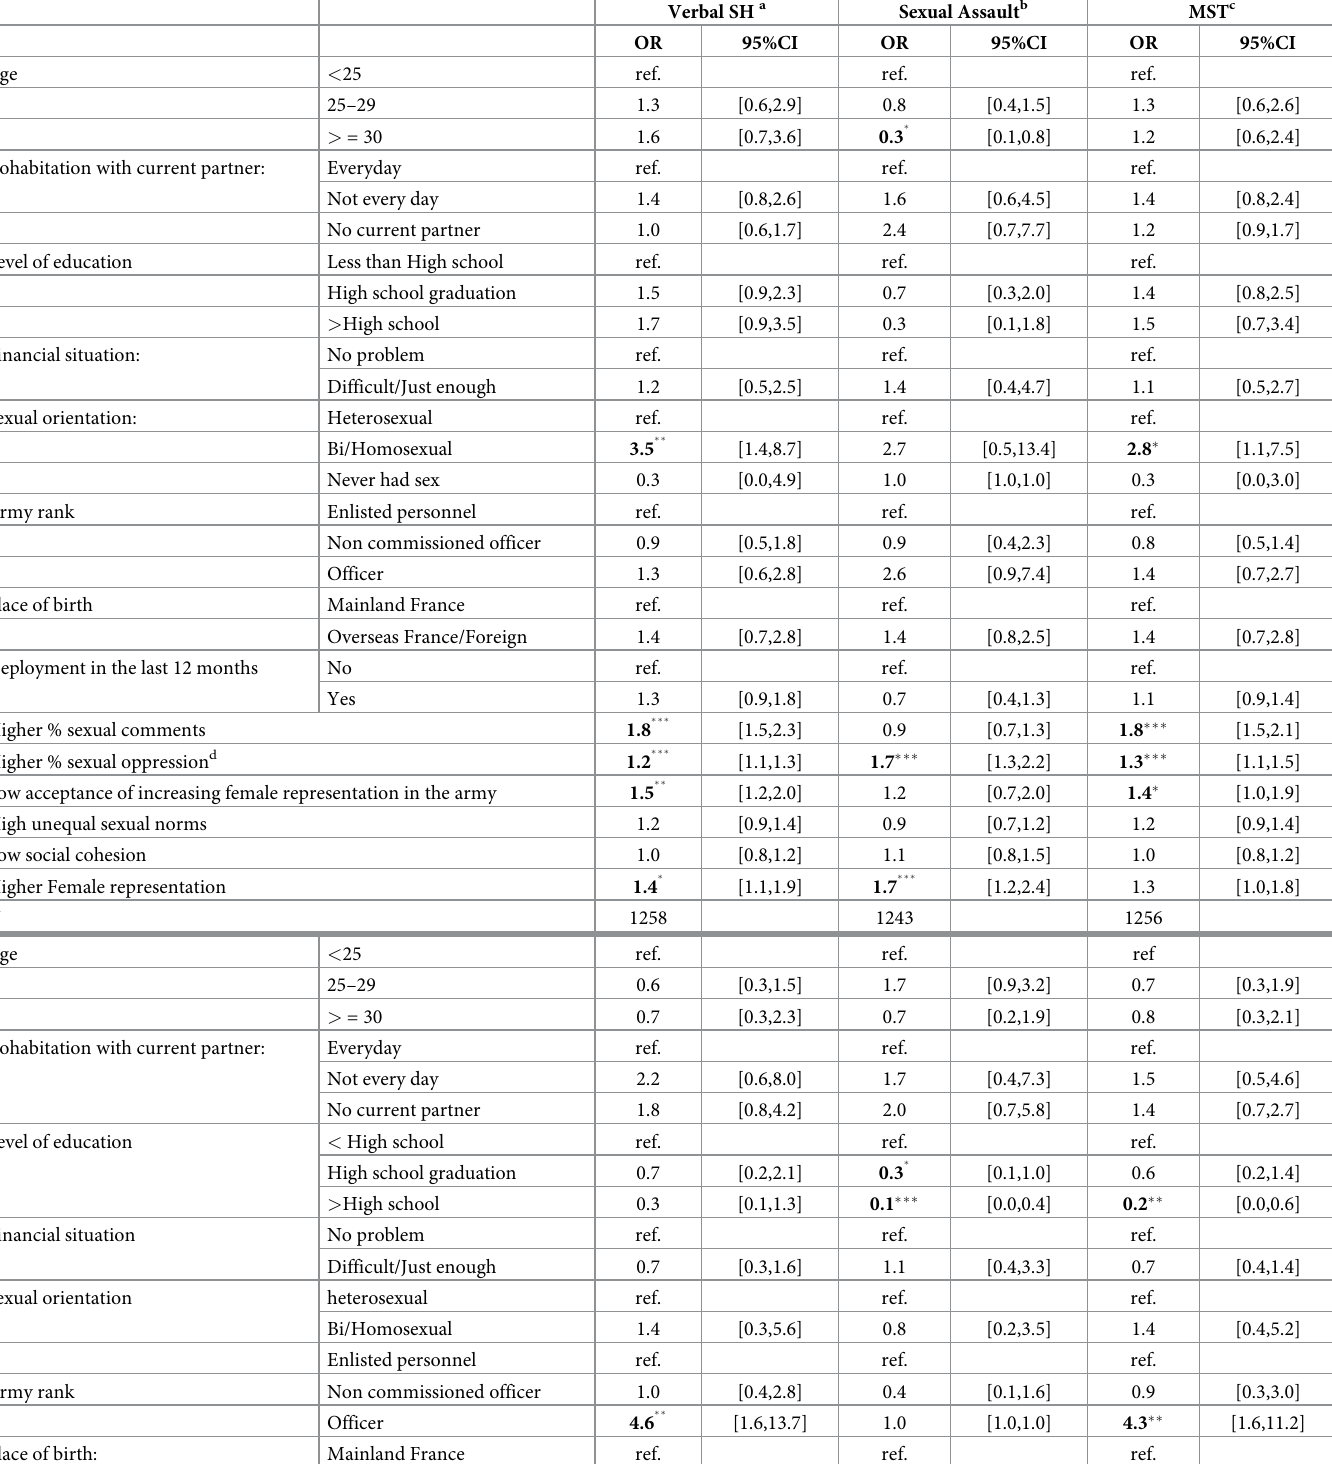
Table 4. a: Multivariate analysis of Verbal SH , Sexual Assault , and MST in the military work environment in the last 12 months among men. b: Multivariate analysis of Verbal SH , Sexual Assault Sexual Oppression and MST in the military work environment in the last 12 months among